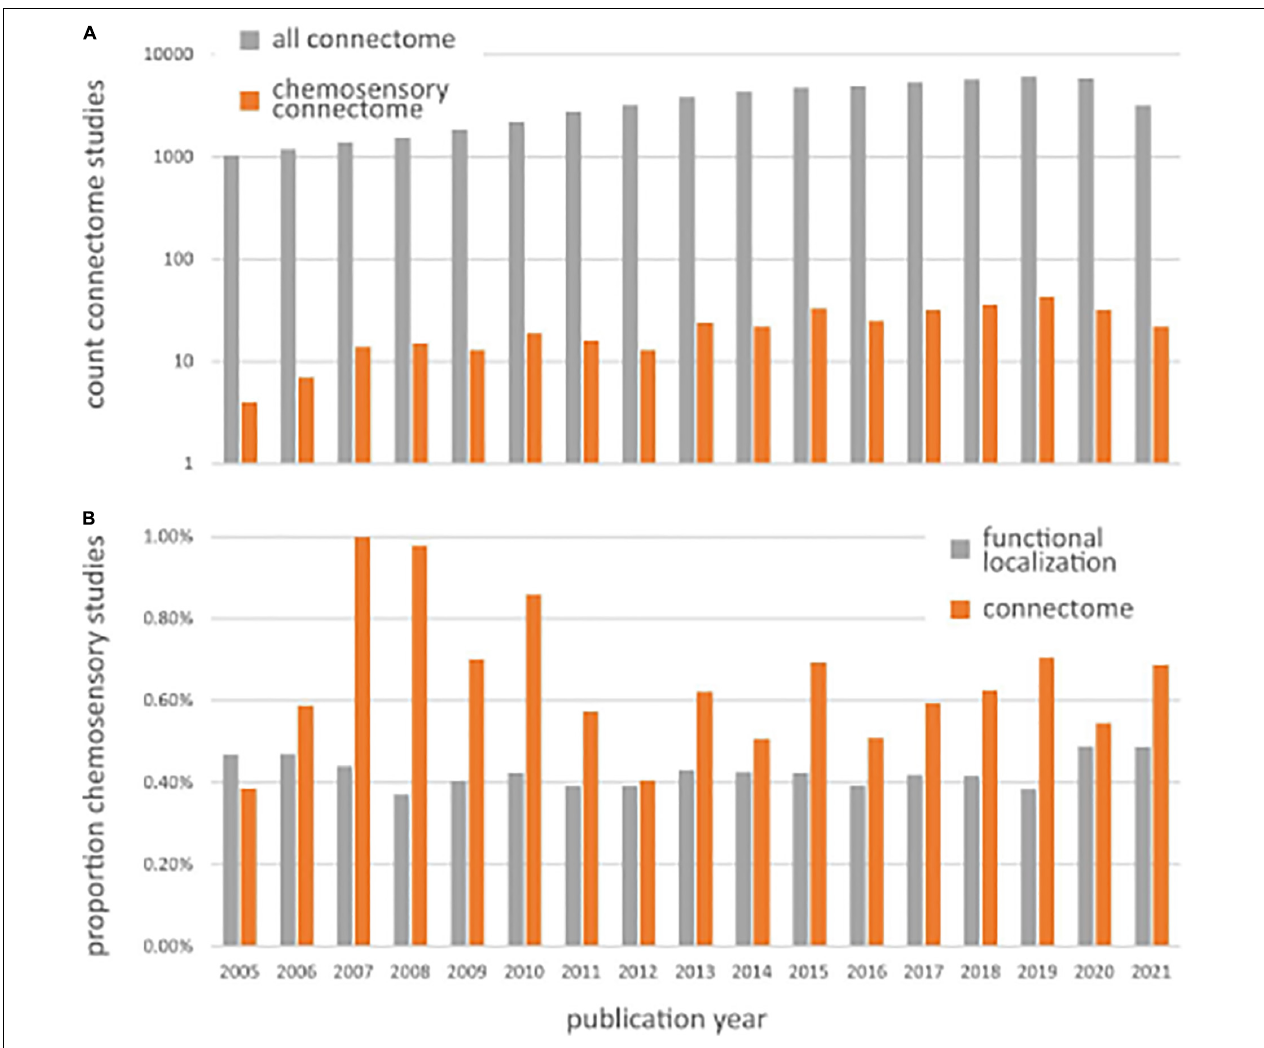
FIGURE 1 | (A) Number of Pubmed search results for chemosensory connectomes (orange bars), returned from the query “human AND (chemosensory OR olfaction OR gustation) AND (connectome OR connectivity) AND (neuroimaging OR brain OR fMRI OR EEG OR MEG)” and all connectomes (gray bars), returned from the query “human AND (connectivity OR connectome) AND (neuroimaging OR fMRI OR brain OR EEG OR MEG).” (B) Chemosensory neuroimaging studies expressed as a proportion of the total number of studies using general neuroimaging methods (gray bars), returned from query “human AND (neuroimaging OR fMRI OR brain OR EEG OR MEG)” and chemosensory connectome studies expressed as a proportion of the total number of studies using connectome methods (gray bars), returned from the query “human AND (connectivity OR connectome) AND (neuroimaging OR fMRI OR brain OR EEG OR